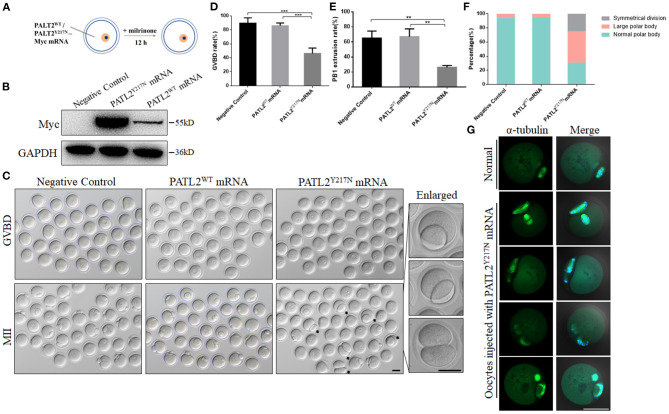
Pathogenicity of Y217N variant in mouse oocyte. (A) Illustration of mRNA microinjection in (B–G). (B) Expression of PATL2WT and PATL2Y217N cRNA after microinjection was verified by Western blot analysis. (C) Phase-contrast images of negative control and PATL2WT or PATL2Y217N cRNA injected oocytes. Black arrows indicate oocytes with apparent abnormal polar body. Enlarged images of oocytes with large polar body and symmetrical division are arranged in the right line. Scale bars indicate 50 μm. (D,E) Quantitative analysis of GVBD rate (D) and Pb1 extrusion rate (E) Graphs show means ± SD of results observed in three independent experiments. **P < 0.01, ***p < 0.001 (F) The proportion of the normal polar body, large polar body and symmetrical division in negative control and PATL2WT or PATL2Y217N cRNA injected oocytes. Total number of oocytes analyzed: n = 184 for negative control oocytes; n = 200 for PATL2WT cRNA injected oocytes; n = 74 for PATL2Y217N cRNA injected oocytes. P < 0.017 was considered to be statistically significant by Pearson chi square test. (G) Spindle defects and chromosome misalignment were detected in PATL2Y217N cRNA injected oocytes. Scale bar indicates 50 μm.